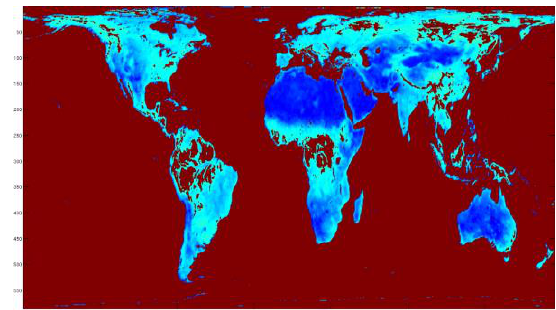
Figure 1. The flowchart of the major steps of the algorithm.